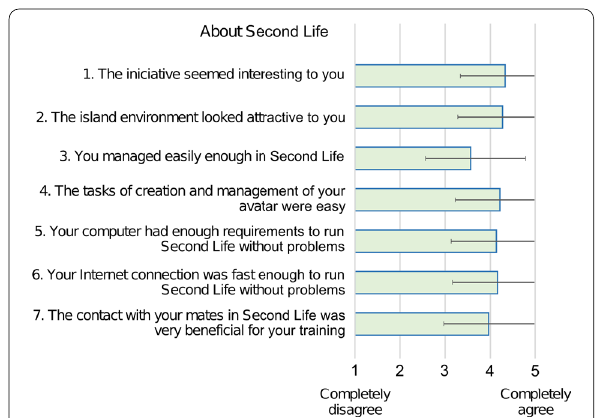
Fig. 5 Bar diagram expressing the mean of the results of the evaluation questionnaire about Second Life on a five‑point Likert scale. Error bars represent the standard deviation